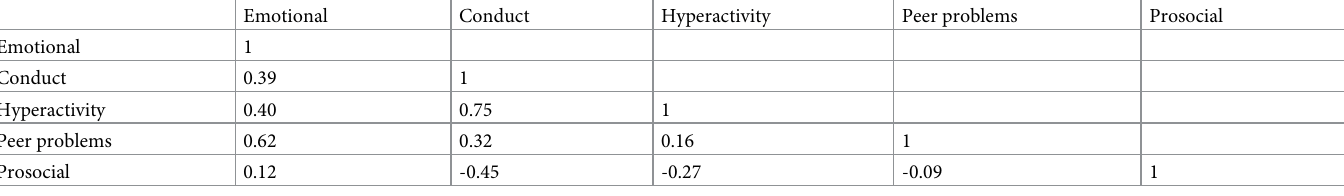
Table 4. Correlations between latent factors from model